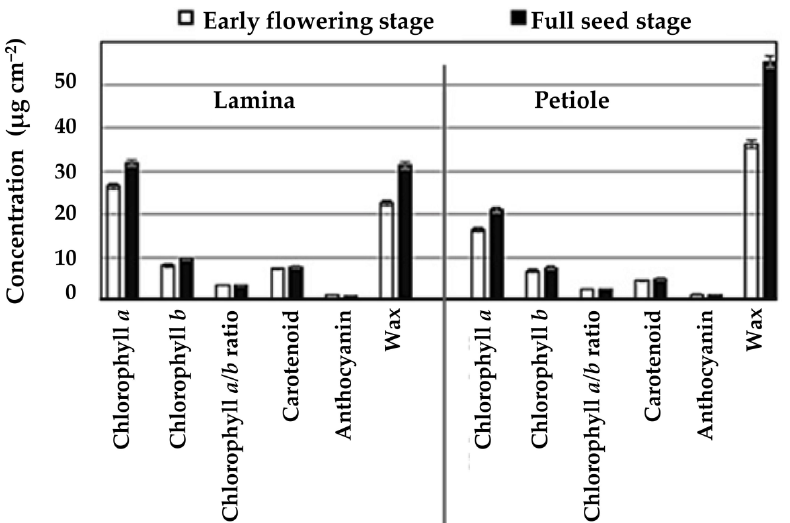
Figure 2. Chlorophyll a, b, a/b, carotenoid, anthocyanin and wax concentrations (µg cm − 2 of tissue) in leaf lamina and petiole at early flowering and flower termination stages of pea grown in six field environments in Saskatchewan, Canada (2014 to 2016). Each bar is the mean value averaged over 24 cultivars, six environments and four replications per environment, i.e., N = 576 for each variable. Generally, for chlorophyll and carotenoid concentrations under both control and heat stress, the normal leafed vining cultivars with dark green canopies had the greatest chlo- rophyll a, chlorophyll b, and carotenoid concentrations; but the least chlorophyll and ca- rotenoid concentrations were found in normal leafed vining cultivars with bright green color (Figure 3A,B,D). Under control and heat stress, bright green cultivars had a higher chlorophyll a/b ratio than dark green cultivars regardless of the growth habit and leaf type (Figure 3C). Under control conditions, normal leafed vining cultivars with bright green canopies had lower anthocyanin concentration than all other types; but under heat stress this type had a relatively greater anthocyanin concentration than other types (Figure 3E). For leaf wax, under control conditions, semi-leafless cultivars had the same wax concen- tration regardless of their canopy habit and color. The lowest wax concentrations were found in normal leafed vining cultivars with bright green canopies (Figure 3F). Under heat stress, upright semi-leafless cultivars with dark green canopies had the greatest wax concentrations, and normal leafed vining cultivars had the lowest wax concentrations (Figure 3F).